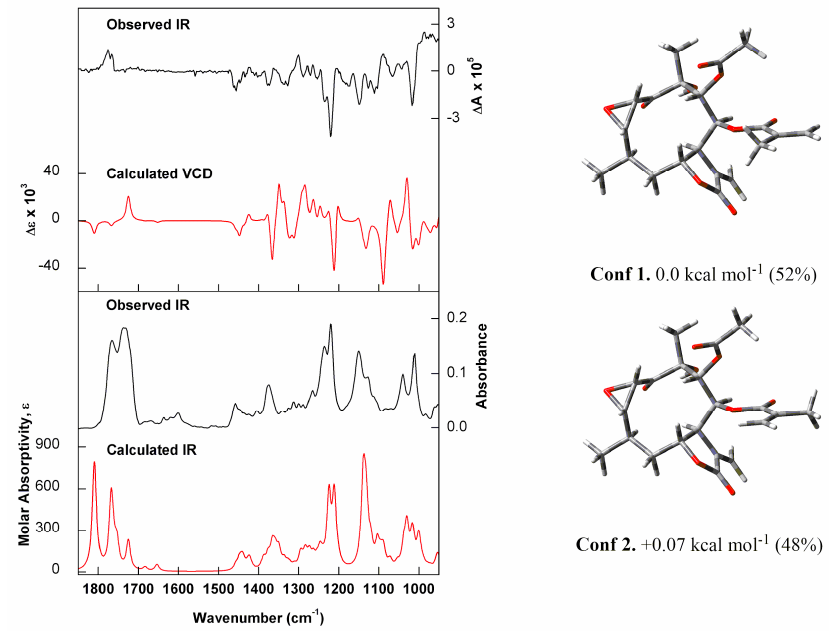
Figure 4. (Left) Comparison of the experimental IR and VCD spectra of ( − )- 2 recorded in CDCl 3 (black trace) with the calculated [B3PW91 / 6-311G(d,p)] IR and VCD spectra for the Boltzmann average of the two lowest-energy conformers identified for (2 S ,3 S ,4 R ,6 R ,7 S ,8 S ,9 R ,10 R )- 2 (red trace). (Right) Optimised structures, relative energies and Boltzmann populations of the lowest-energy conformers identified for (2 S ,3 S ,4 R ,6 R ,7 S ,8 S ,9 R ,10 R )- 2 .